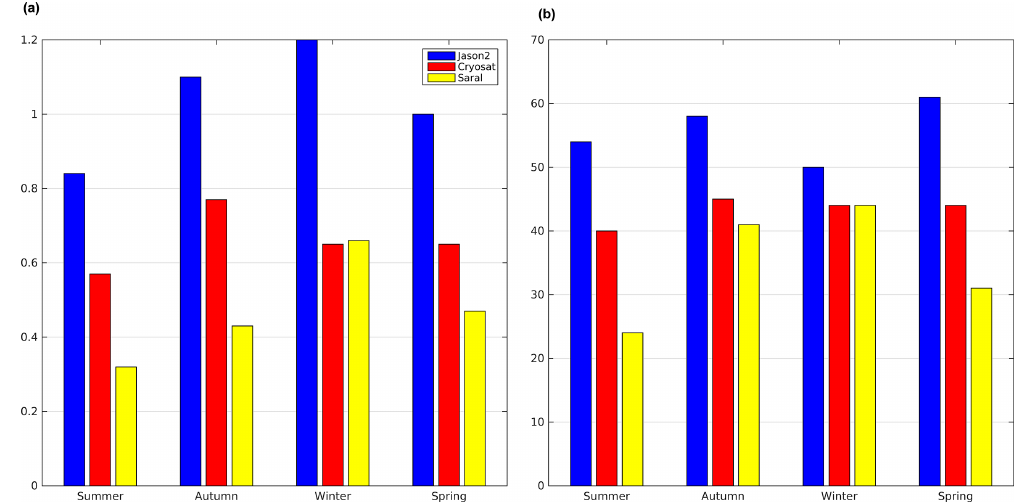
Figure 4. (a) Seasonal noise levels (in 10 − 3 m 2 cpkm − 1 ) for Jason-2 (blue), CryoSat-2 SAR mode (orange) and SARAL/AltiKa (yellow) derived from along-track wavenumber spectra. (b) Seasonal observational limits in terms of wavelength (in km) where the signal-to-noise ratio is >1 for each altimeter mission. Table 1 gives the number of sections